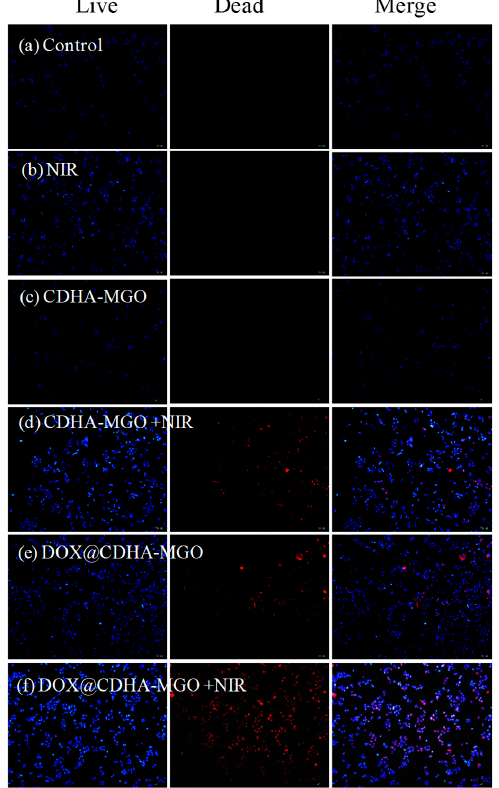
Figure 7. ( a − f ) Fluorescence microscopy images of BEL ‐ 7402 cells under different treatments via LIVE/DEAD staining at the concentration of 20 μ g/mL, with or without NIR laser irradiation (808 nm, 2 W ∙ cm − 2 ) at 37 °C. Blue: Live cells. Red: Dead cells. Bar = 50 μ m.